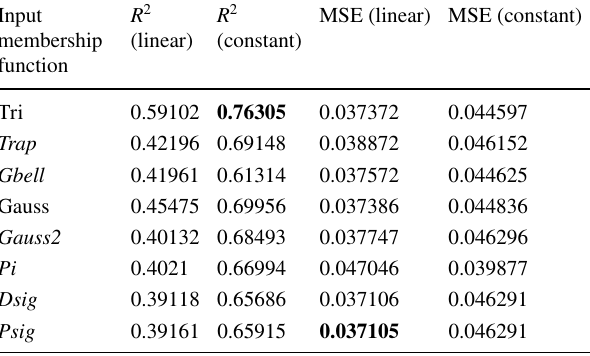
Table 10 ANFIS model efficiency for chromium (VI) removal using LAC